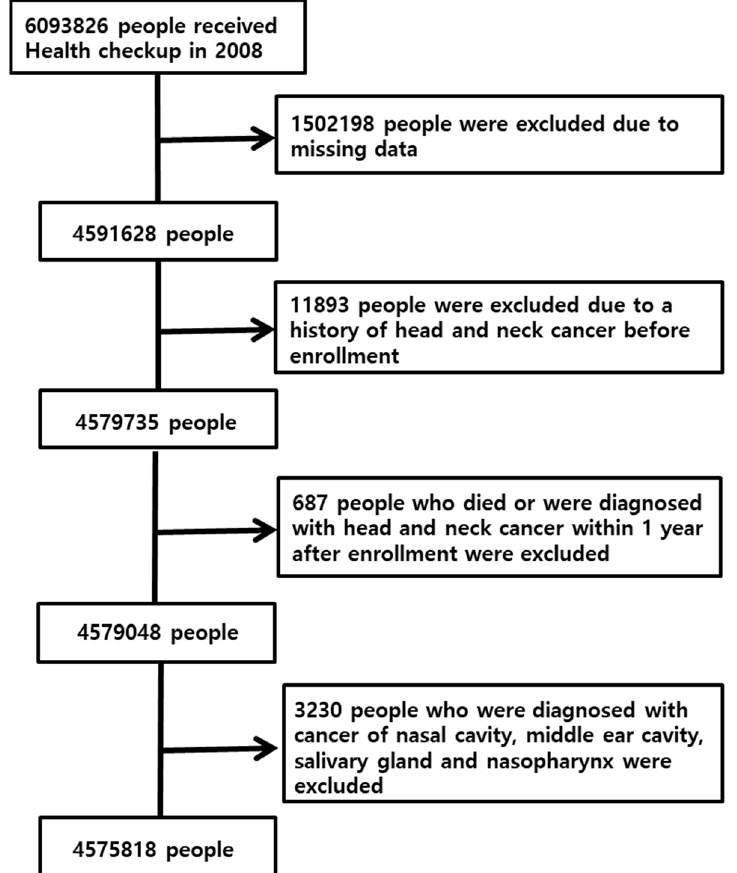
Figure 1. Flow diagram of the study population.